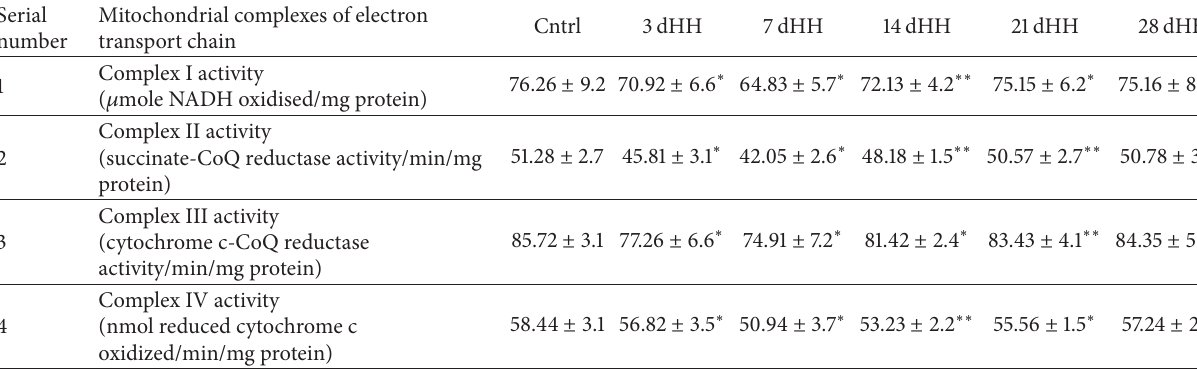
Table 3: Effect of HH on specific activity of respiratory complex